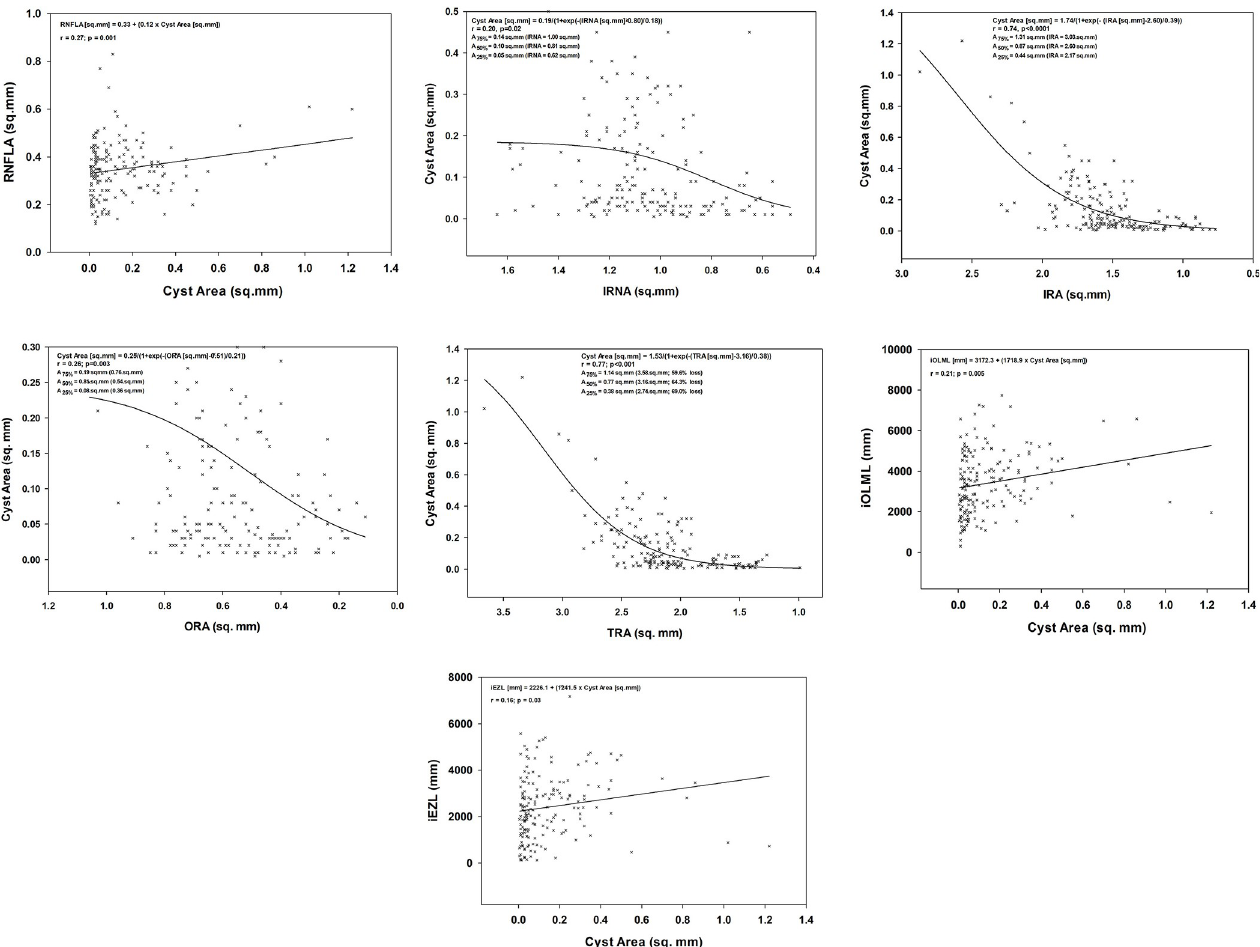
Fig 3. Best-fit curves defining the relationship between cyst size and other retinal anatomical parameters. (A) A significant linear correlation exists between the size of the intraretinal cysts and RNFLA (r = 0.27, p = 0.001), indicating that RNFL becomes thickened at times when intraretinal cysts are at the peak of their size. (B) The change in retinal cyst size and the IRNA can be best expressed with a 3-parameter Sigmoidal curve in the form of f = a/(1+exp(-(x- x0)/b)). Retinal cysts resolve as the IRNA decreases in the late phases of the degenerative process. (r = 0.20, p = 0.02). (C) Intraretinal cysts diminish with the thinning of the inner retina (r = 0.74, p < 0.001). The high correlation is mostly due to the presence of cysts in the inner nuclear layer. (D) Intraretinal cysts are the biggest in the early phases of the disease. As outer retinal retina degenerates, the size of the cysts gets smaller (r = 0.26, p = 0.003). (E) Resolution of intraretinal cysts coincides with decrease in total retinal area (r = 0.77, p < 0.001). (F) There is a positive linear correlation between cyst size and remaining OLM, indicating that cysts develop early in retinal degeneration and fade out as the outer retina degenerates (r = 0.21; p = 0.005). (G) Like iOLML, iEZL positively correlates with the cyst area, indicating that degeneration of the photoreceptors is coupled with the resolution of the cysts (r = 0.16; p = 0.03). https://doi.org/10.1371/journal.pone.0276629.g003 the best visual acuity 0.23 ± 0.18 logMAR (Snellen equivalent: 20/34), followed by subjects with autosomal recessive 0.36 ± 0.29 logMAR (Snellen equivalent: 20/46) and X-linked forms 1.08 ± 0.30 logMAR (Snellen equivalent: 20/240). No significant correlation was detected between the best-corrected visual acuity and patient’s age (r = 0.112; p = 0.091), gender (r = 0.025; p = 0.382), and ORA (r = - 0.072, p = 0.197, Fig 4E, Table 2). Analysis indicated that the impact of cyst size on visual acuity could be best defined with a 2-parameter single rectan- gular hyperbolic curve in the form of f = a � x/(b+x) (r = 0.14, p = 0.05, Fig 4A). This best-fit curve indicates that the development of the cysts can cause a two-line decrease in visual acuity early in the development of the cysts, which becomes stable afterward.